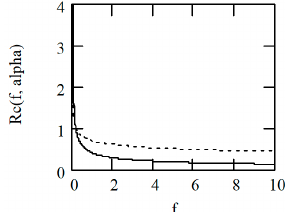
Figure 1. The plots of | Rc ( f , α )|. Solid line: α = 0.5. Dot line: α = 0.8.